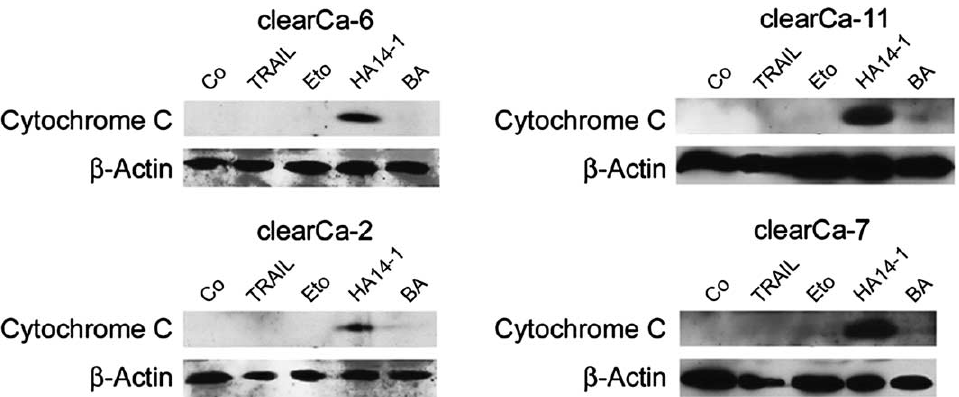
Fig. 5. Western Blot analysis of cytochrome C release after exposure to TRAIL, etoposide, HA14-1 and betulinic acid. Exposure of RCC cell lines to 100 ng/ml TRAIL for 12 h, 50 µg/ml etoposide for 12 h, 50 µM HA14-1 for 1 h (clearCa-2, clearCa-7, clearCa-11) respectively 3 h (clearCa-6) and 40 µM betulinic acid (BA) for 12 h resulted in a cytochrome C release only after exposure to the BCL2-antagonist HA14-1. No detectable cytochrome C release after exposure to TRAIL, etoposide or betulinic